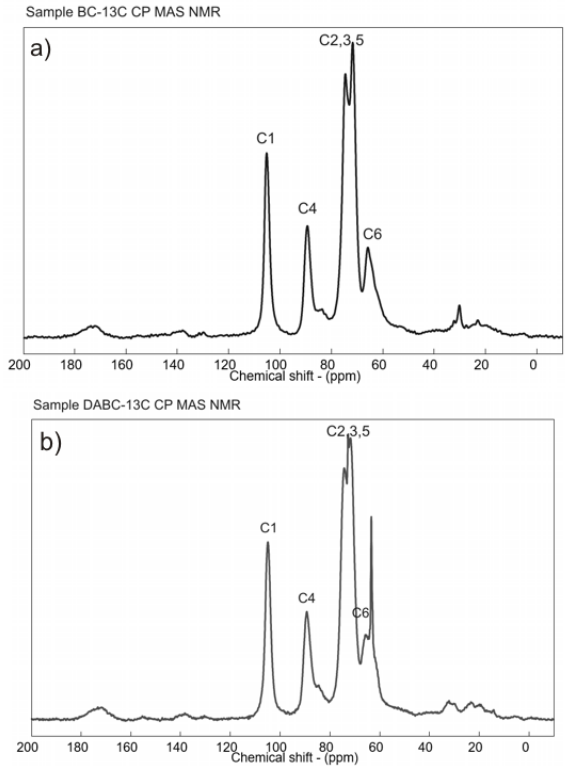
13 C solid-state NMR spectra of ( a ) BC and ( b ) Figure 5 . 13 C solid ‐ state NMR spectra of ( a ) BC and ( b ) DABC. Figure 5.